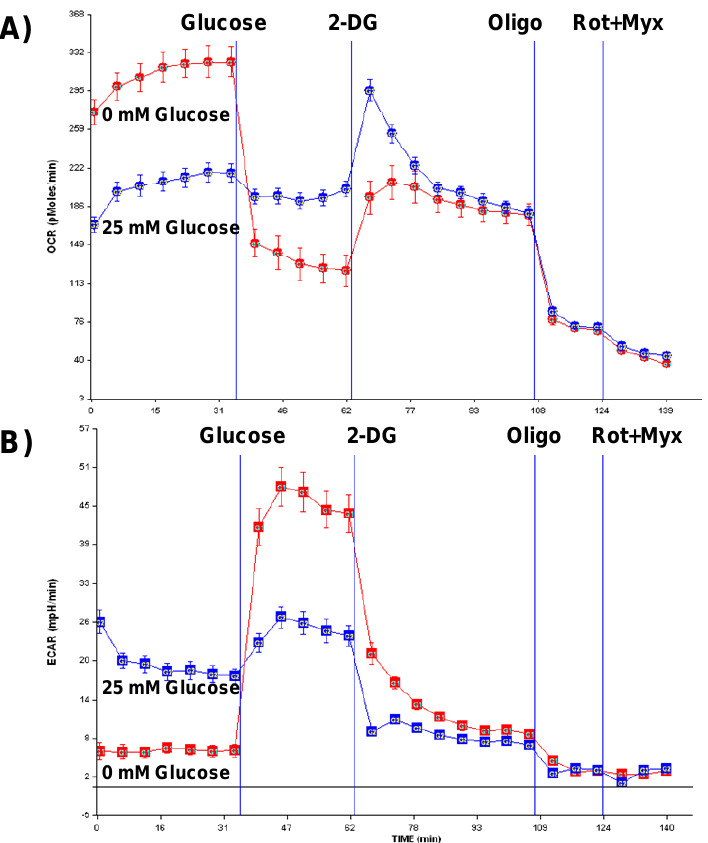
Figure 2. In human neuroblastoma cells, glucose starvation increases mitochondrial respiration without inducing obvious mitochondrial biogenesis. The data in this figure were produced using an XF24 Flux Analzyer (Seahorse Biosciences). At the start of the experiment SH-SY5Y cells were maintained in either normal DMEM medium (control cells) or in DMEM containing no glucose (starved cells); at the time these measurements were taken the starved cell had been without glucose for 15 hours. Glucose starved cell metabolic physiology is indicated by orange lines, and control cell metabolic physiology is indicated by blue lines. Panel (A) shows the oxygen consumption rates (OCR) of cells maintained under the two conditions, and panel (B) shows the extracellular acidification rate (ECAR) that is mostly due to lactate excretion. After baseline OCR and ECAR values are established, glucose was injected in the mediums, and this had a profound effect on the starved but not the control cells. The glycolysis inhibitor 2-deoxyglucose was next injected, which rapidly increased the control cell OCR to the level it was in the 15 hour starved cells. This was followed by injection of the ATP synthase inhibitor oligomycin, which terminates coupled mitochondrial respiration. Lastly, the complex I and III inhibitors rotenone and myxothiazol were used to stop the residual uncoupled mitochondrial respiration, so only non-mitochondrial oxygen consumption remains. After oligomycin and again after rotenone and myxothiazol the OCR values for both the control and starved cells were similar, indicating in the experiment starved and control cell numbers were equivalent. Additional details pertaining to this experiment are provided in the text. 2 DG=2 deoxyglucose; oligo=oligomycin; rot=rotenone;